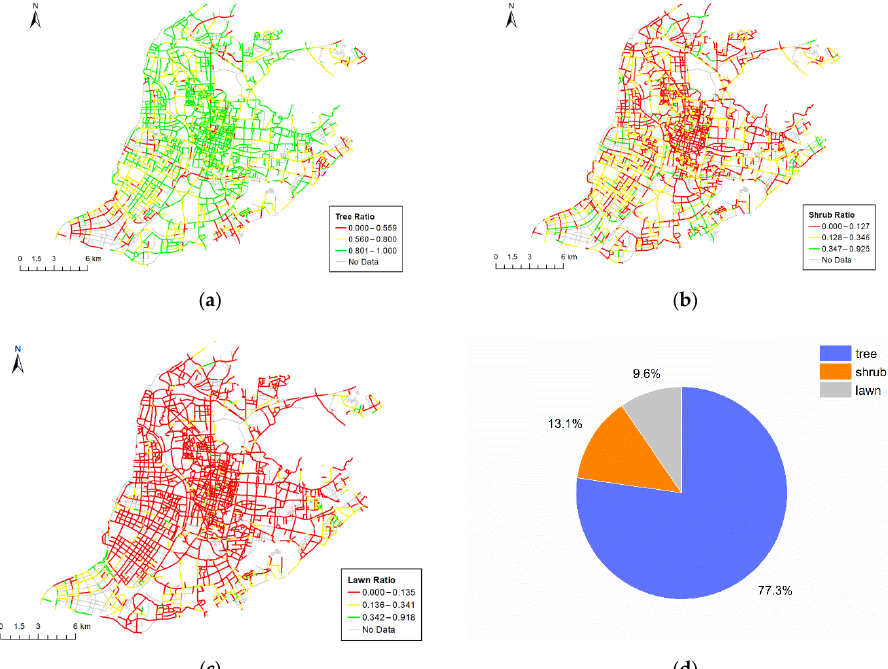
Figure 12. Vegetation compositions of the research area. Levels were classified by the natural break method. ( a ) The proportion of trees. ( b ) The proportion of shrubs. ( c ) The proportion of lawns. ( d ) Proportions of the three vegetation types. Forests 2020 , 11 , x FOR PEER REVIEW